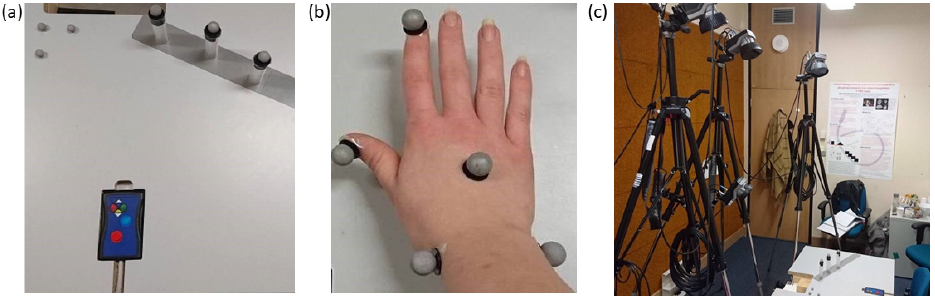
Figure 2. ( a ) Top-down view of the task apparatus: button box in centre of the participant’s midline with the blue button to indicate trial start and the red button to press and hold until objects illuminated one of the 3 cylindrical, translucent objects connected to the VPixx system (VPixx Technologies 2018) and programmed to illuminate, with reflective markers attached to the top for motion capture cameras. ( b ) A participant’s right hand with reflective markers attached to the index finger, thumb, back of hand, medial wrist and lateral wrist. ( c ) The set-up of the four Qualisys cameras [56] in relation to the task apparatus, consistent through all